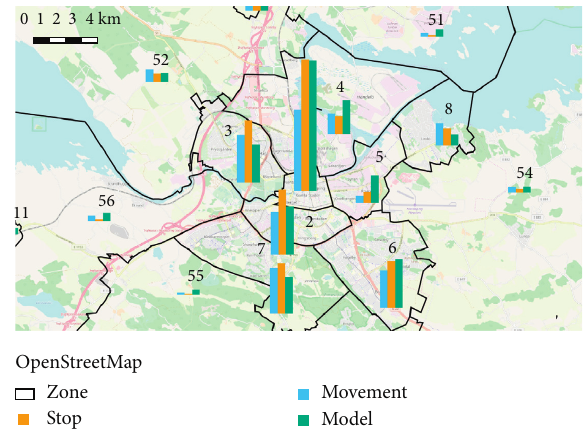
Figure 16: Zoneflow (total inflow+outflow) inferred from cellular network data in comparison with the model (TAZ-24 zoning). Zone internal flows and OD pairs with origin/destination outside of the municipality are not included.